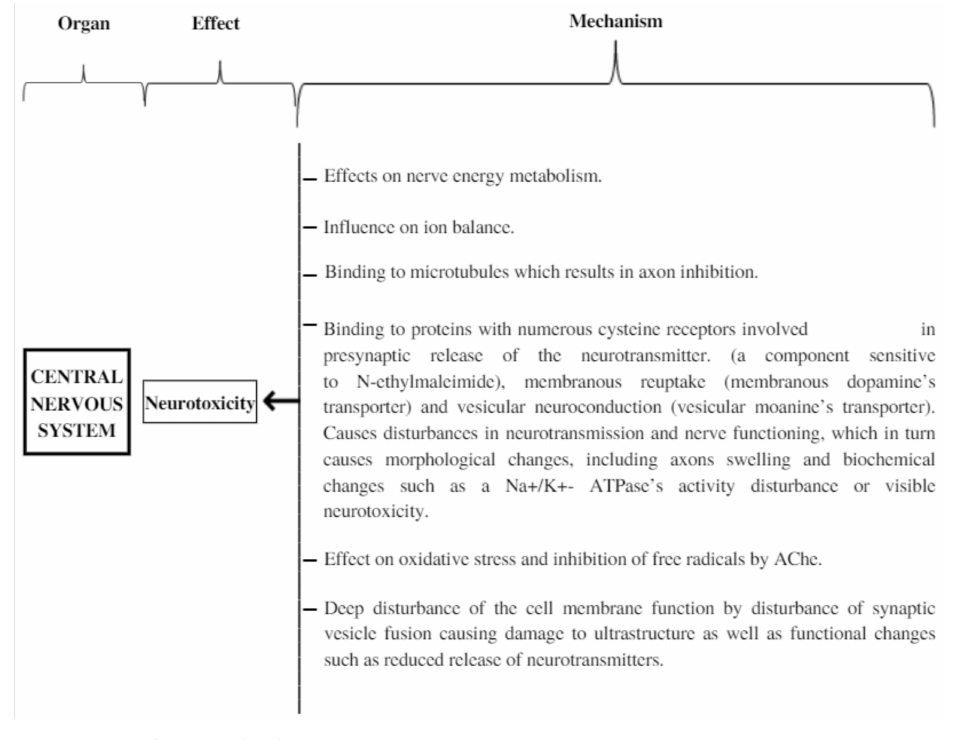
Figure 3. Mechanisms leading to